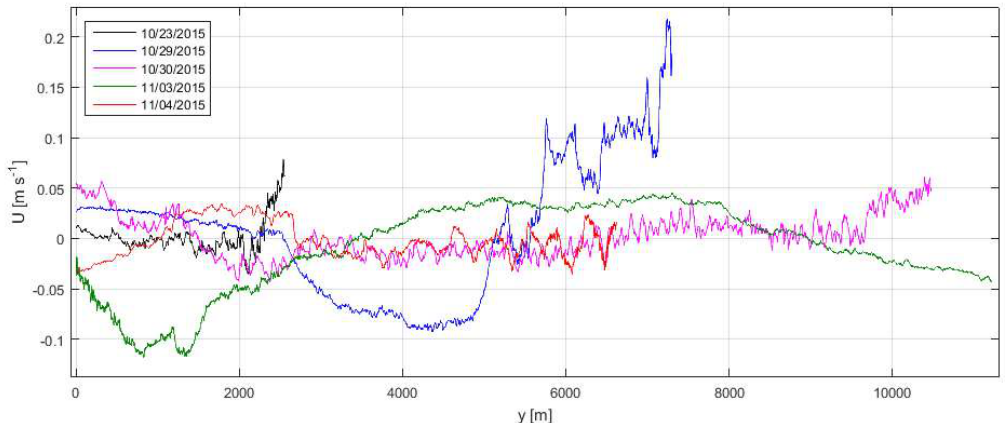
Figure 12. Values of across-plume velocities U given at every meter along the plume, starting with the oldest end of each plume at y = 0. Five curves correspond to five different plumes surveyed on different days, specified in the legend.